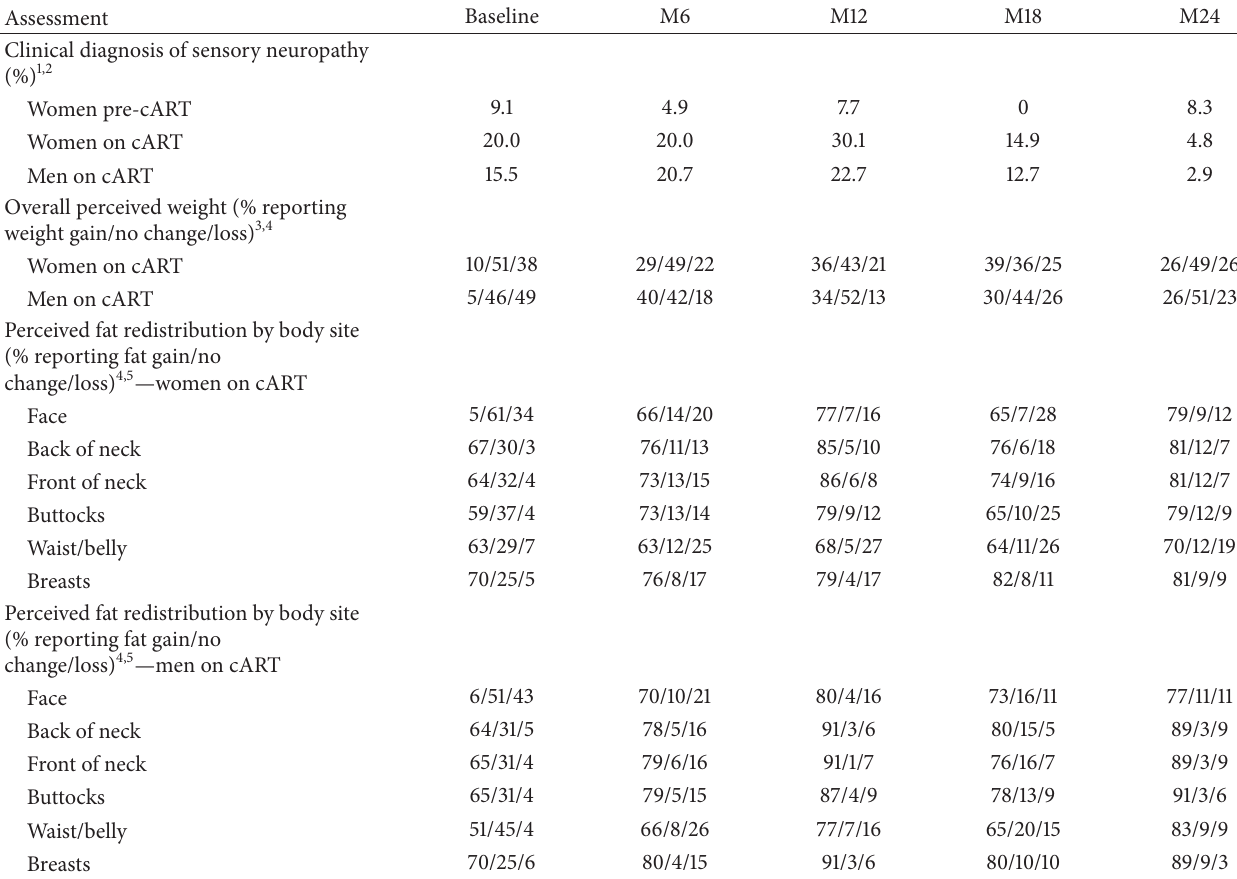
Table 3: Proportion of women and men on cART with sensory neuropathy or perceived fat redistribution during follow-up.